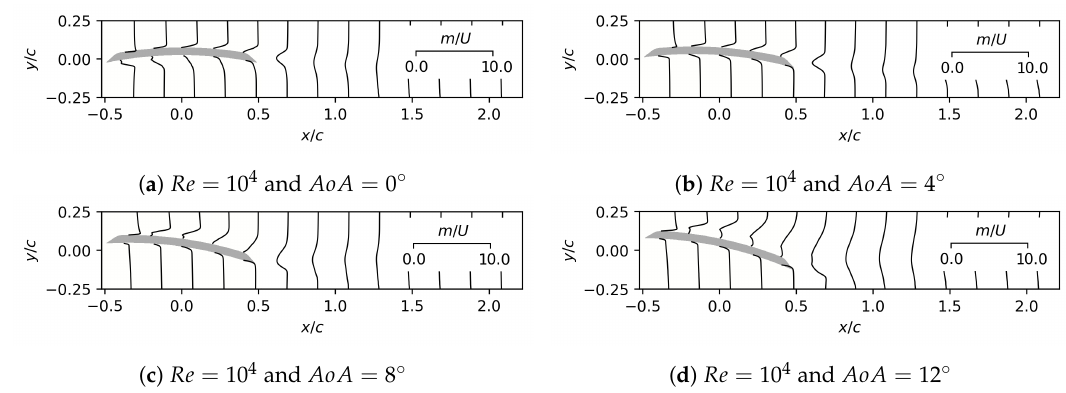
Figure A1. Profile of non-dimensional magnitude of mean velocity m / U at x / c = − 0.4, −